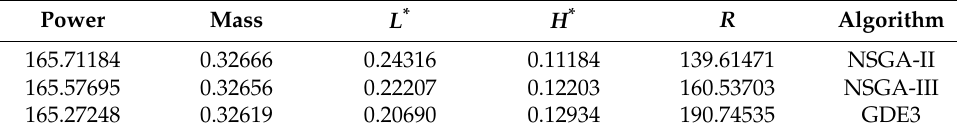
Table 6. Some solutions belonging to the optimal Pareto front of [14]. Power Mass L * H * R